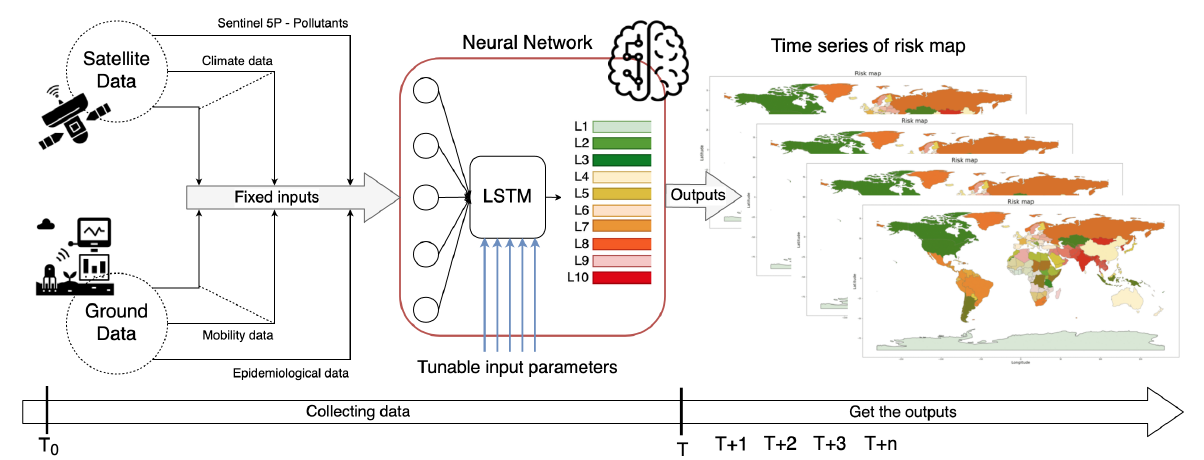
Figure 2. Block diagram of the adopted